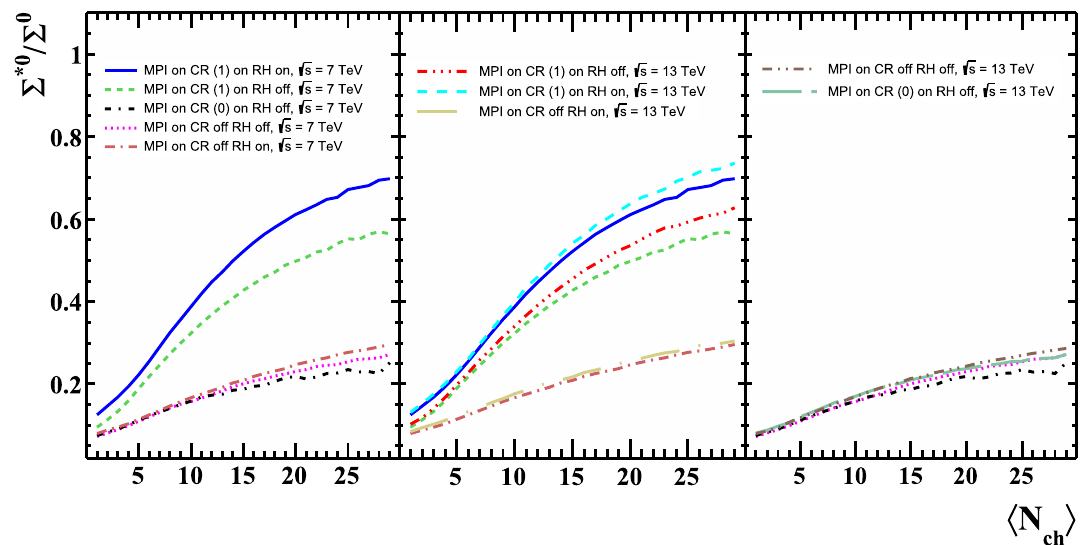
√ s = 7 TeV and 13 TeV for CR-off, CR(0) and CR(1) with RH. (Right panel) Comparison of ratios for p–p collisions √ s = 7 TeV and 13 TeV for two other modes, namely CR-off and CR(0) without